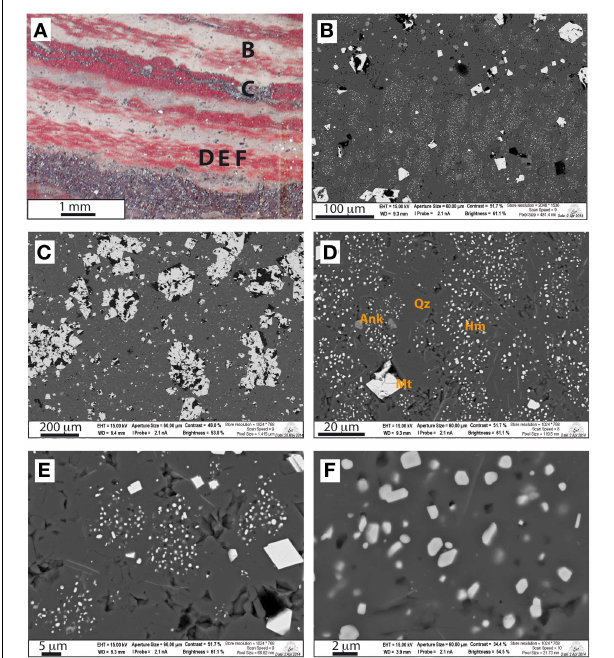
FIGURE 2 | Optical and SEM representative images of iron oxides for sample 130.45. (A) optical microscope image with indications of the area observed with the SEM; (B) SEM image at the transition between gray and red areas; (C) bulky iron oxides within the white gray area interpreted as being magnetite; (D) patches of small euhedral to rounded iron oxide grains interpreted as hematite in the red layers, Qz, quartz; Ank, ankerite; Mt, magnetite; Hm, hematite; (E) small iron oxide grains, interpreted as hematite with bigger grains population interpreted as magnetite and (F) high magnification image of small hematite